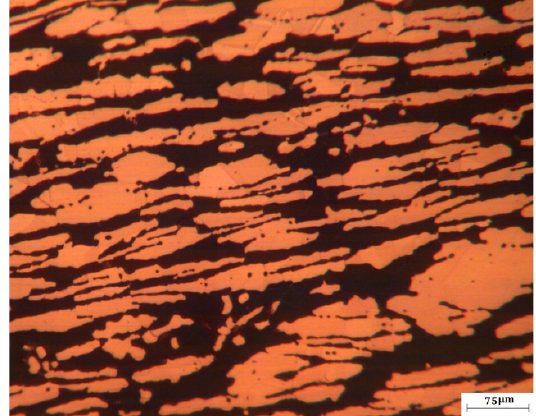
Figure 7. Optical micrograph from the BM: austenite and ferrite (dark phase).